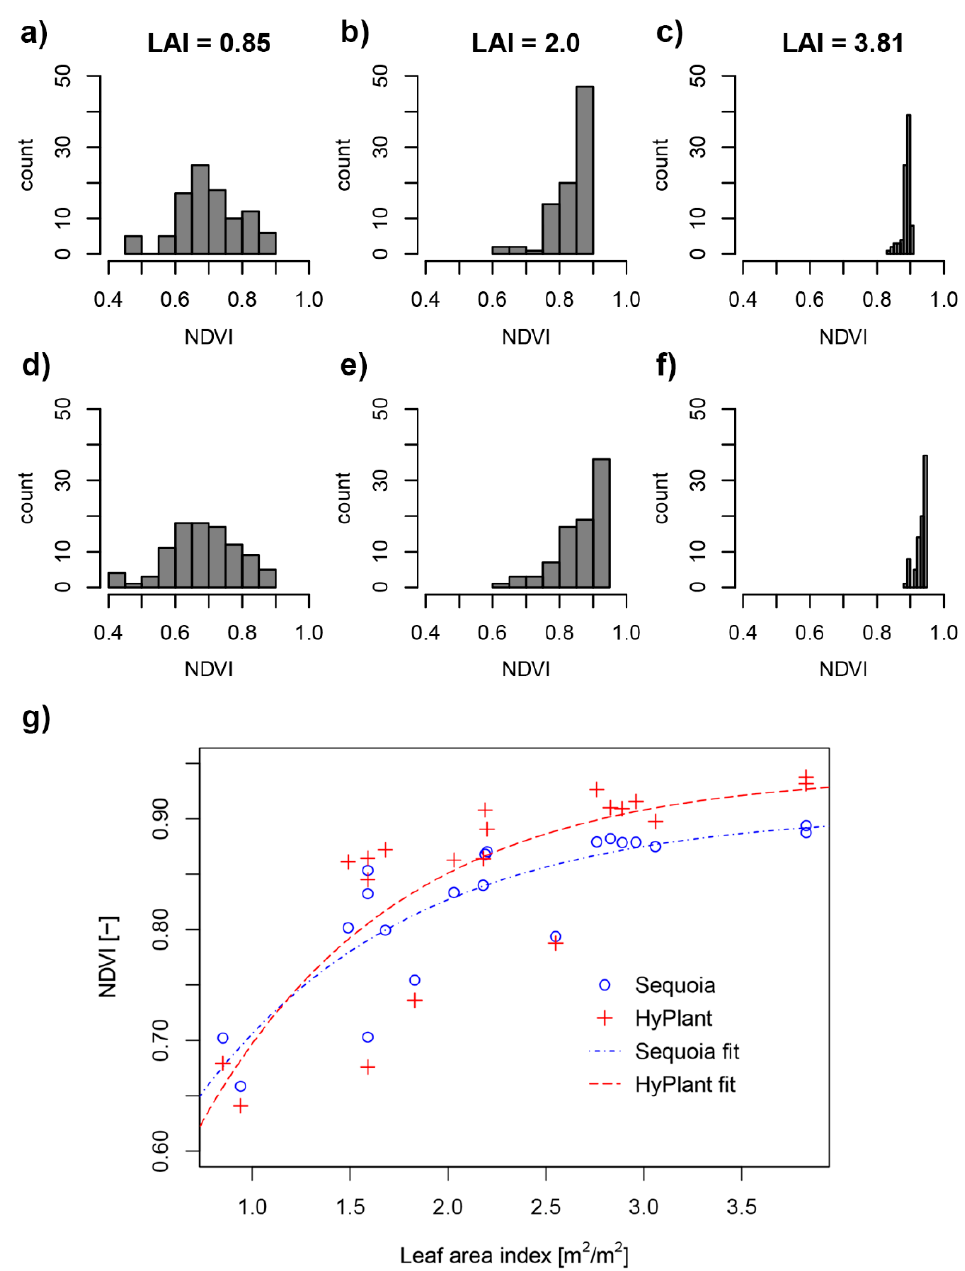
Figure 11. Histograms of Sequoia ( a – c ) and HyPlant ( d – f ) NDVI values for three 10 × 10 m ESUs of varying LAI. ( g ) NDVI values averaged over ESU extents and the corresponding LAI value measured in the field. Non-linear model fits are provided for illustrative purposes.